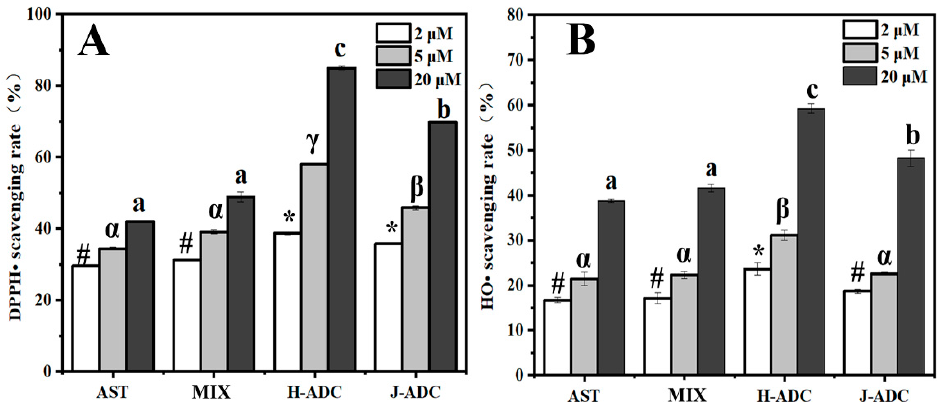
Figure 5. (A ) DPPH• scavenging rate of different samples; ( B ) HO• scavenging rate of different samples. #, *, α – γ , a–d different letters and symbols show statistically significant differences ( p < 0.05) between different groups, whereas bars labelled with the same letter correspond to results that show no statistically significant differences.